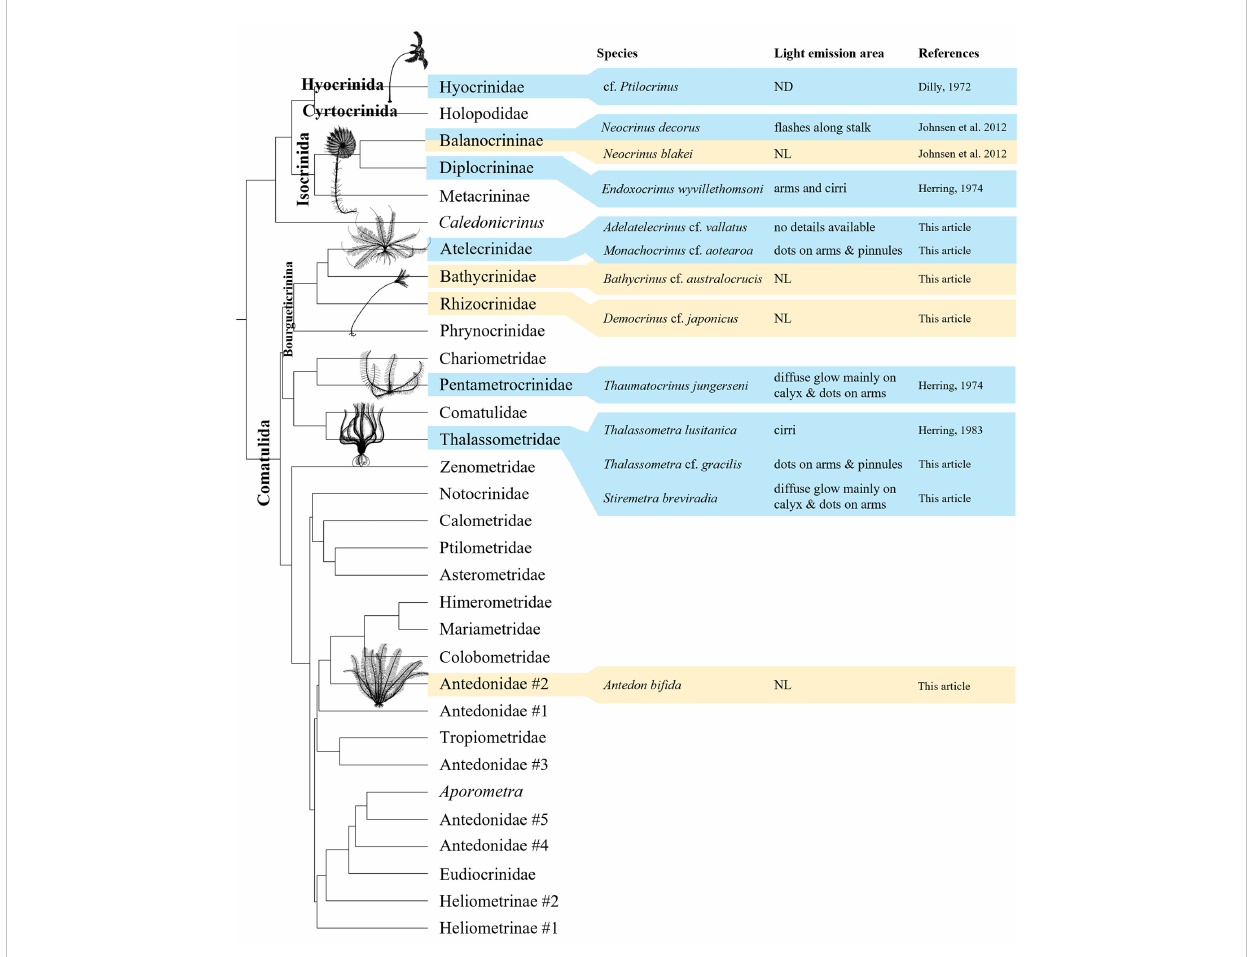
FIGURE 4 Distribution of luminescence within the class Crinoidea according to the classi fi cation based on the latest molecular advancements (Hemery et al., 2013). Clades presenting bioluminescent species are indicated in blue while clades with only non-bioluminescent tested species are in light yellow. Classi fi cation of Balanocrininae and Rhizocrinidae follows respectively Ame ́ ziane et al., 2021 and Roux et al., 2019 (contra Hess and Messing, 2011). Original drawings made by